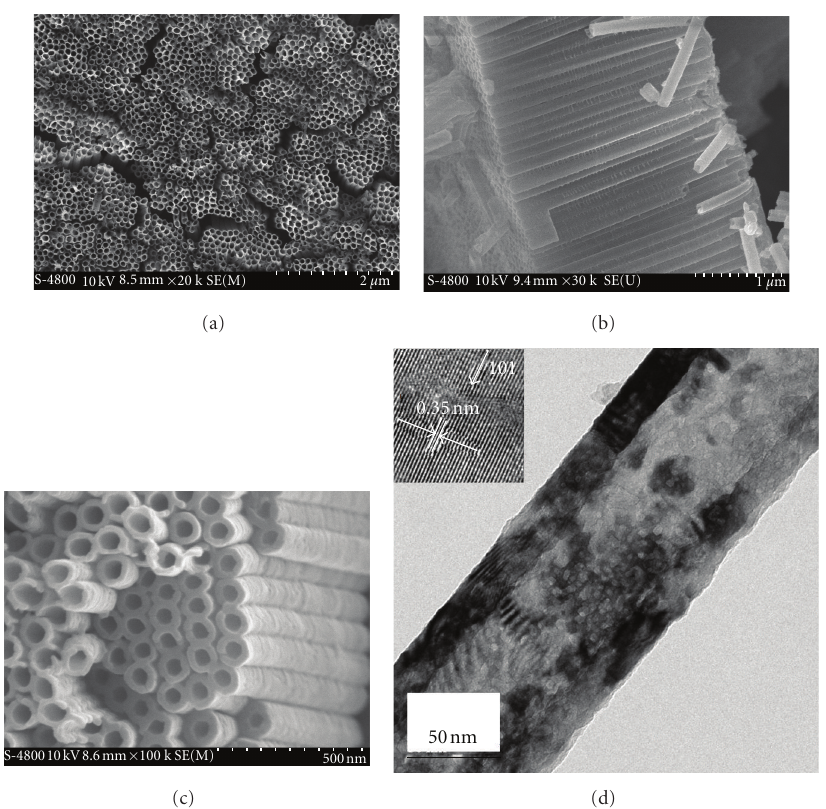
Figure 1: FESEM top-view images (a) and cross-section (b) of TiO 2 nanotube arrays and the magnified image of the TiO 2 nanotube arrays after annealing (c). TEM images of a typical annealed single TiO 2 nanotube (d) and high magnification image showing a lattice spacing of 0.35nm, corresponding to anatase phase (inset).